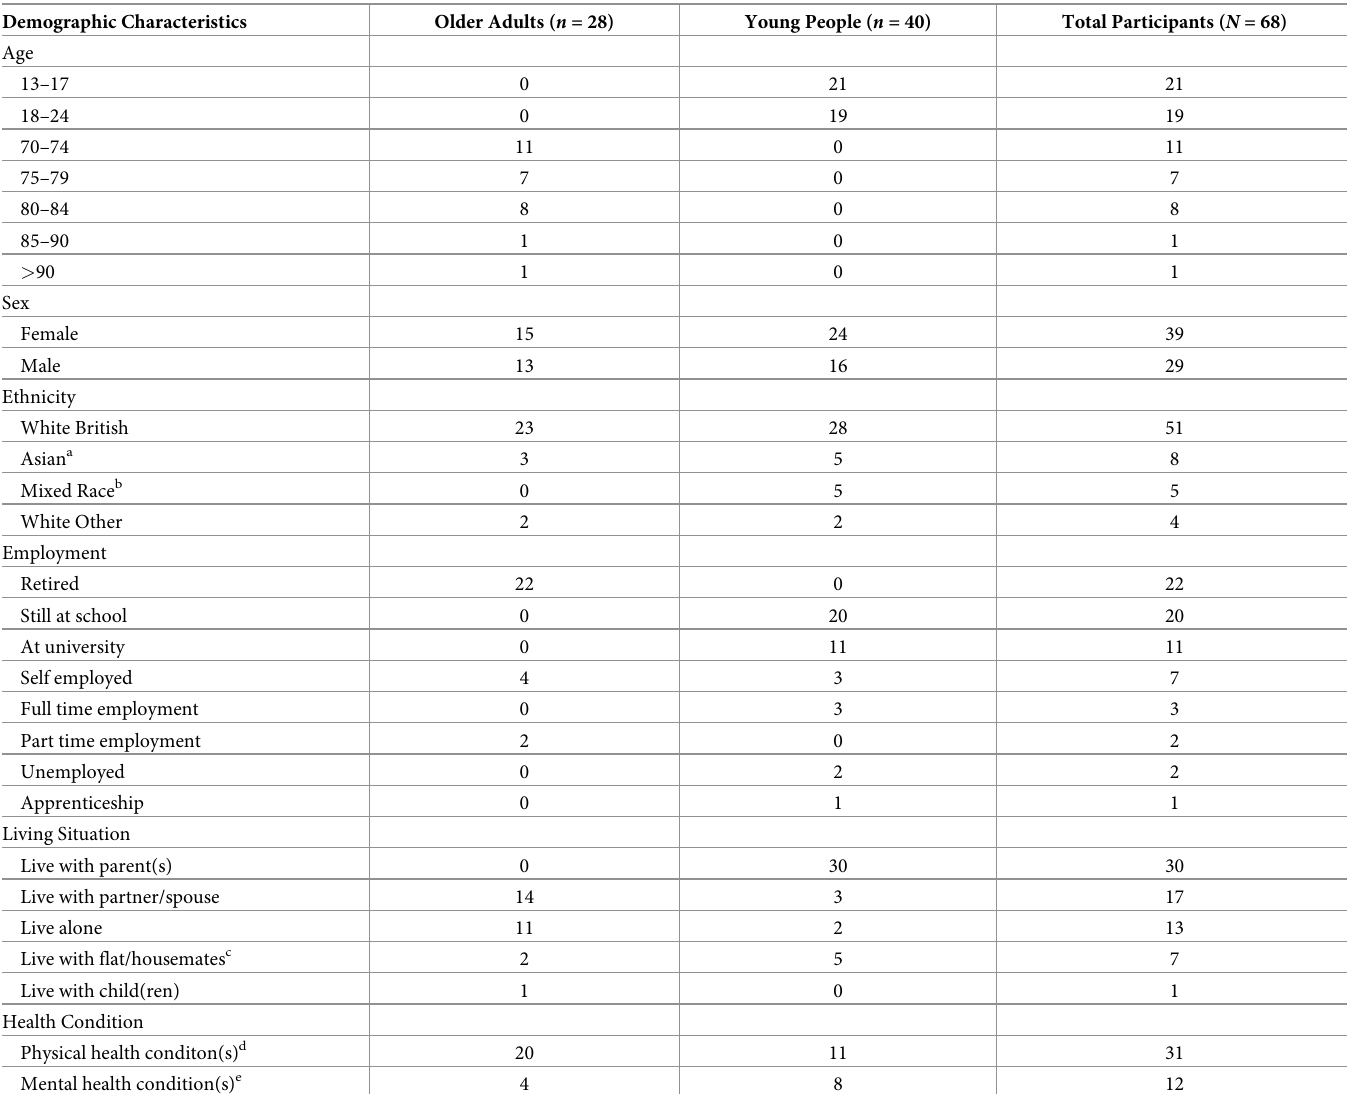
Table 1. Self-reported demographic characteristics of participants. Demographic